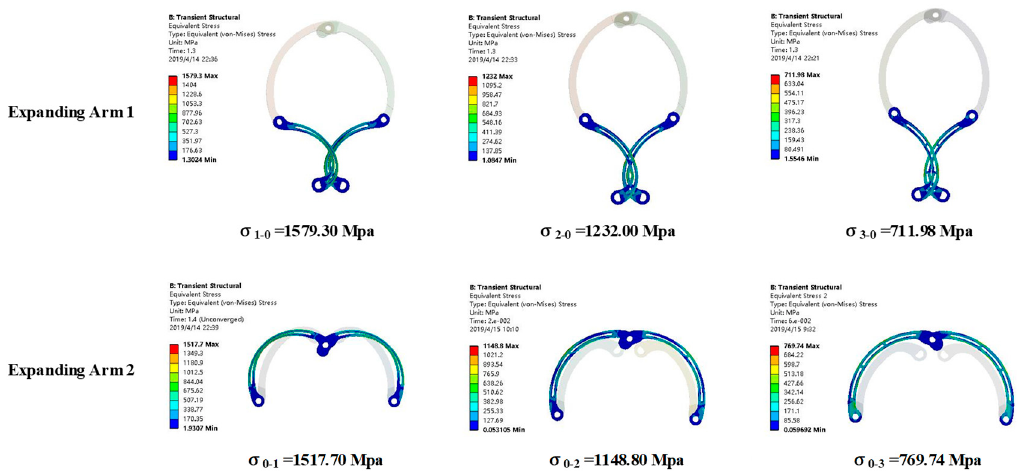
Figure 14. Optimization process of the expanding arm.